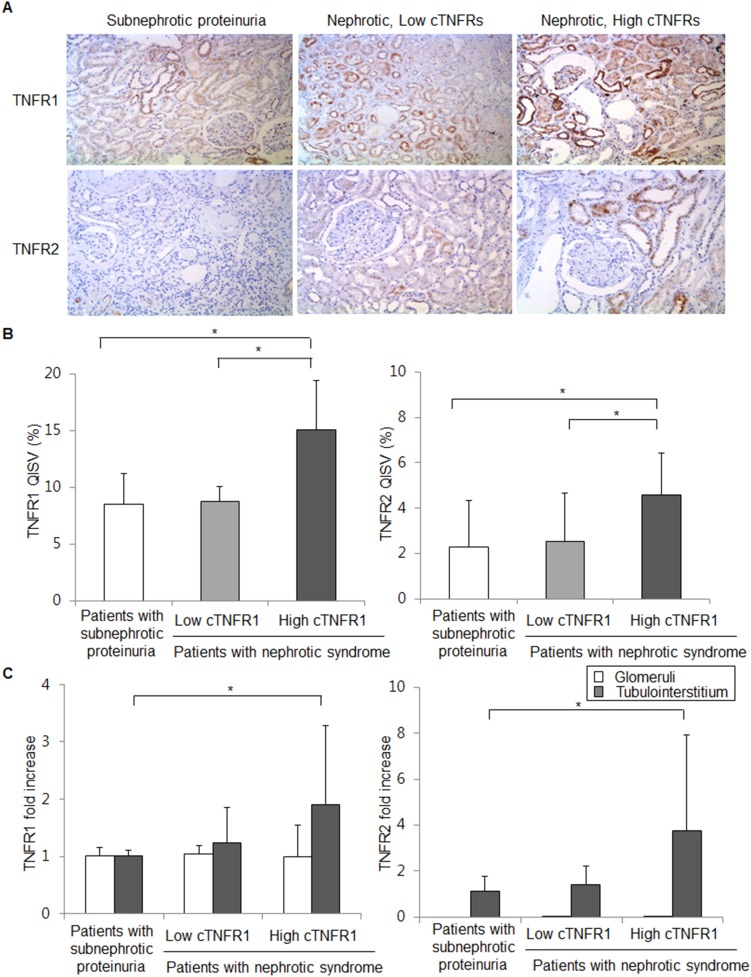
Renal expression of TNFRs according to circulating TNFRs.(A) Immunohistochemical staining of TNFRs expression in paraffin-embedded kidney biopsy sections. TNFR1 is expressed in the glomeruli and tubules in the patients with subnephrotic proteinuria, low cTNFRs levels, and high cTNFRs levels, respectively. TNFR2 is expressed in the tubules but rarely in the glomeruli in the patients with subnephrotic proteinuria, low cTNFRs levels, and high cTNFRs levels, respectively. The intensity of the TNFR2 expression was relatively weaker than that of TNFR1 expression. Original magnification, ×20. (B) Quantitative immunohistochemical analysis of renal TNFRs expression. The quantitative immunohistochemical staining value (QISV, %) was calculated as the integrated optical density divided by the total area occupied by the stained sections in each slide by using computer-assisted quantitative analysis (Qwin3, Leica, Rijswijk, Netherlands). (C) Renal expression of TNFRs in the glomeruli or tubules by performing real-time quantitative reverse transcription-polymerase chain reaction. The Kruskal-Wallis test with Dunn’s method was used. *P<0.05.